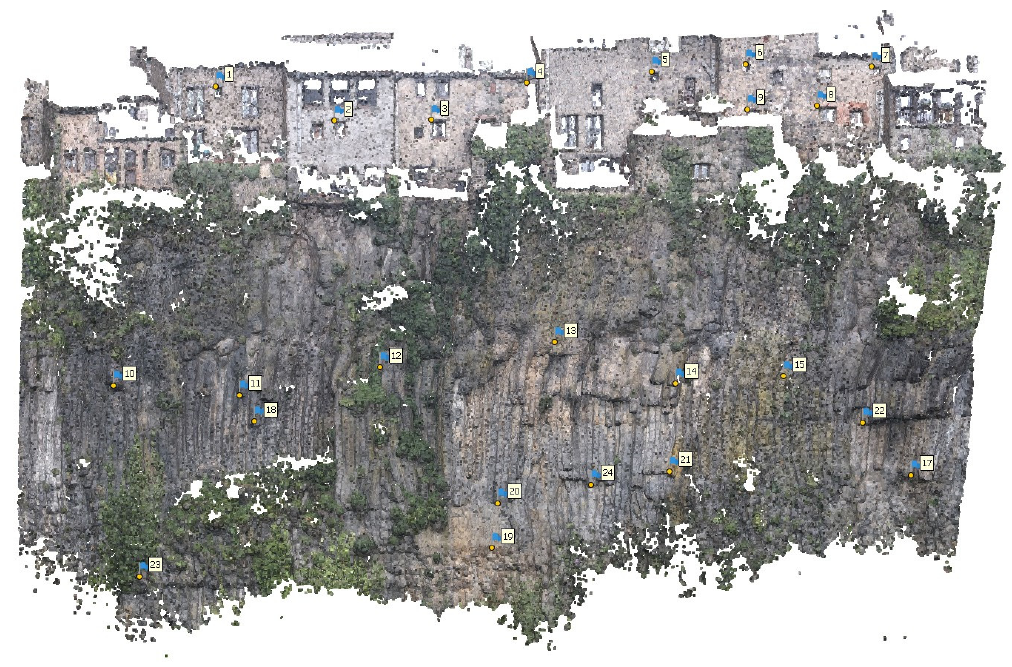
Figure 6. Photogrammetric model and distribution of control points.